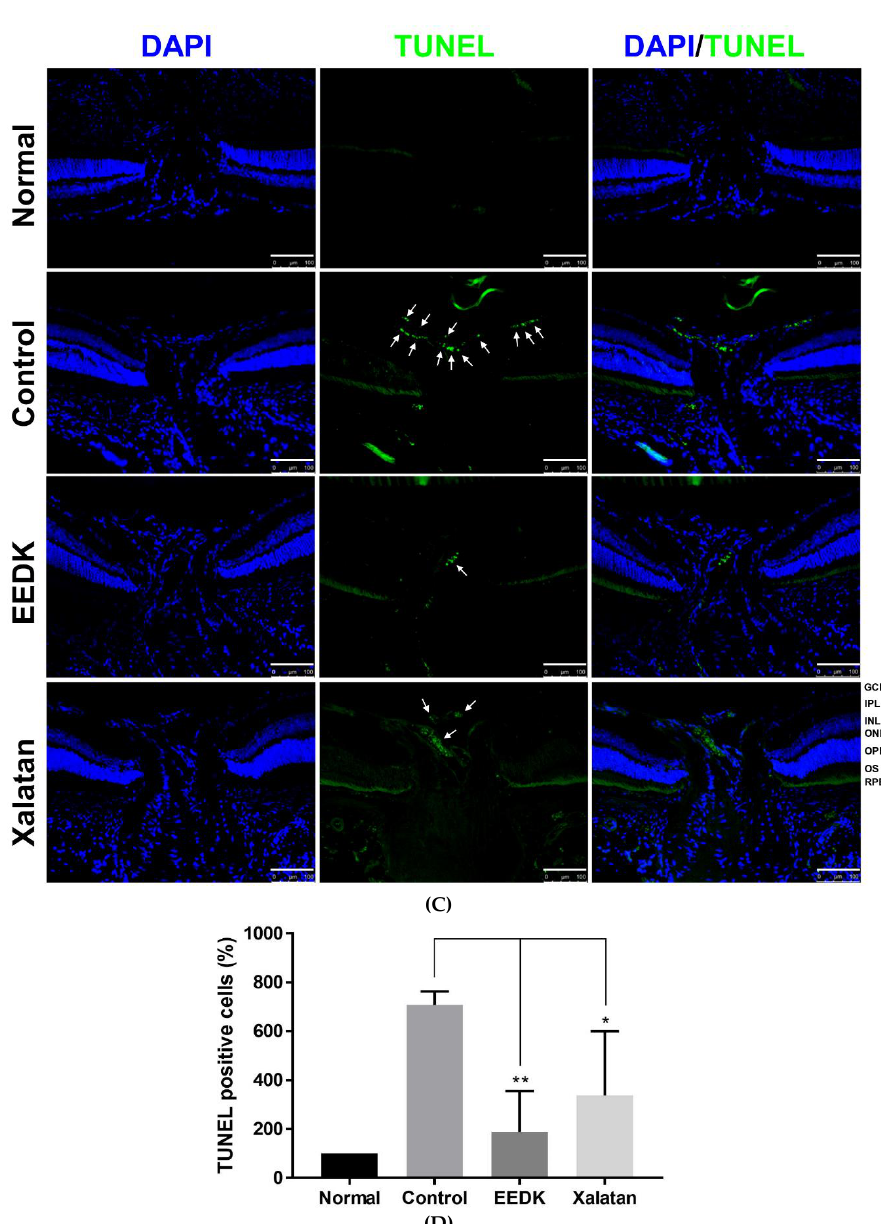
Figure 6. Effect of EEDK on optic nerve head damage in DBA/2 mouse. ( A ) Enucleated eyeballs were fixed for paraffin embedding. The tissue slides were stained by H&E solution. Optic nerve heads of retinas were observed using Nanozoomer. Scale bar = 500 μ m ( B ) The bar graph shows quantitative analysis of the optic disc cupping. Values represent the mean ± S.E.M. for 3 animals (*** p < 0.001, mean ± S.E.M.). ( C ) Cell death in damaged tissue was analyzed by TUNEL assay. The tissue on glass slide was fixed and immunostained with TUNEL assay kit, according to the manufacturer’s protocol. The immunoreactivity was observed by fluorescence microscope. Scale bar represents 100 µ m. GCL, ganglion cell layer; IPL, inner plexiform layer; INL, inner nuclear layer; OPL, outer plexiform layer; ONL, outer nuclear layer; OS, outer segment; RPE, retinal pigment epithelia; ON, optic nerve. ( D ) The bar graph shows quantitative analysis of the TUNEL positive cell rate (%). Values represent the mean ± S.E.M. for 3 animals (* p < 0.05, ** p < 0.01, mean ±